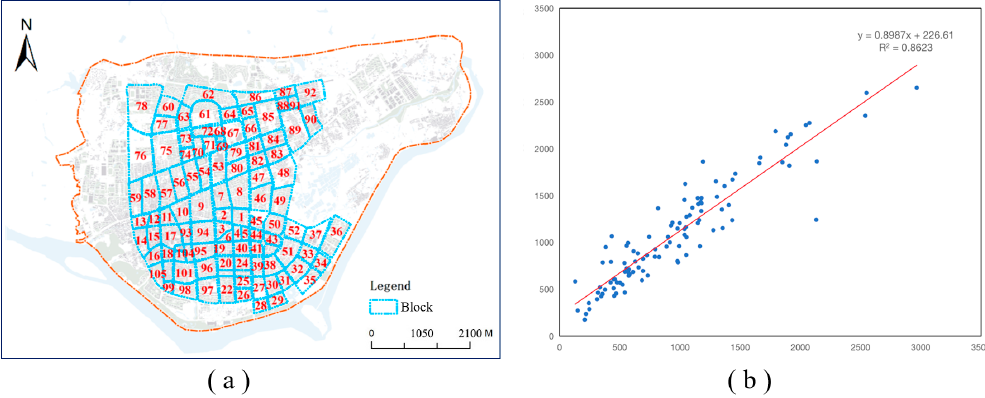
Figure 5. Accuracy evaluation: ( a ) divided assessment unit; ( b ) scatterplot between WorldPop and redistribution results.